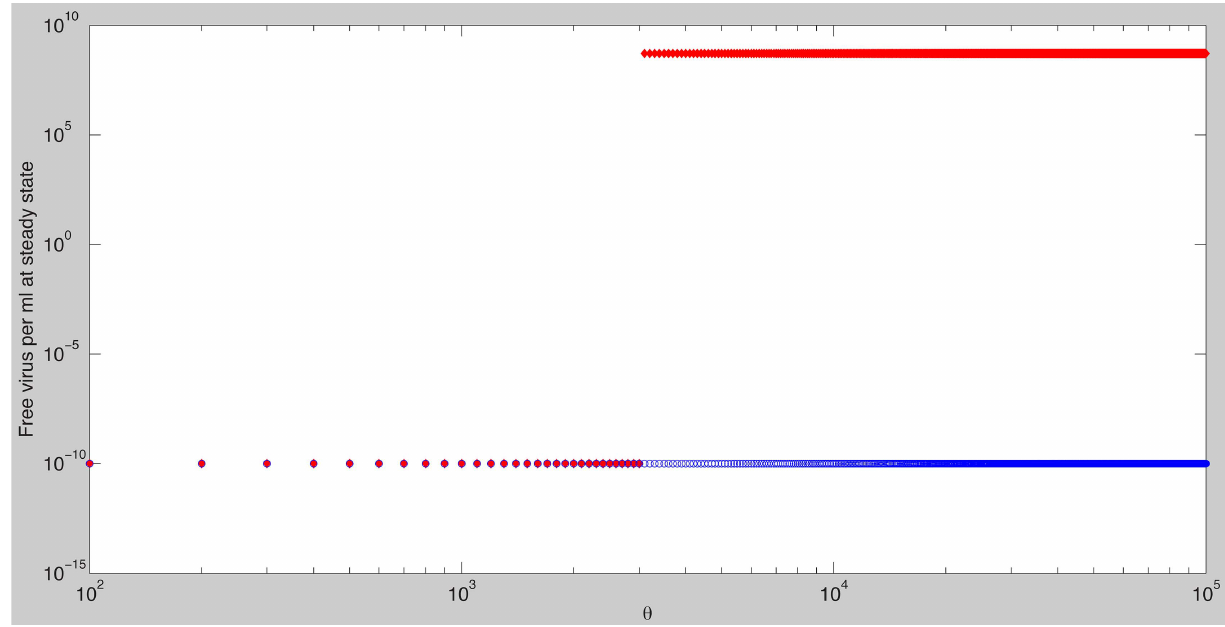
PLOS Computational Biology |